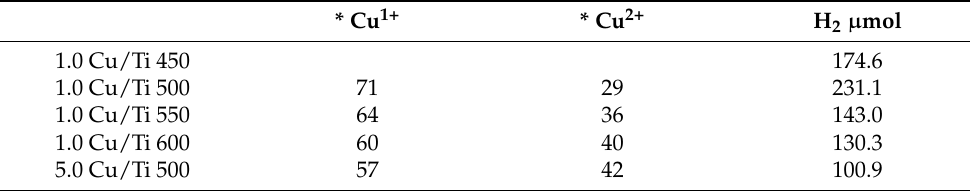
Table 3. Proportion of copper species and hydrogen produced after 8 h of reaction.